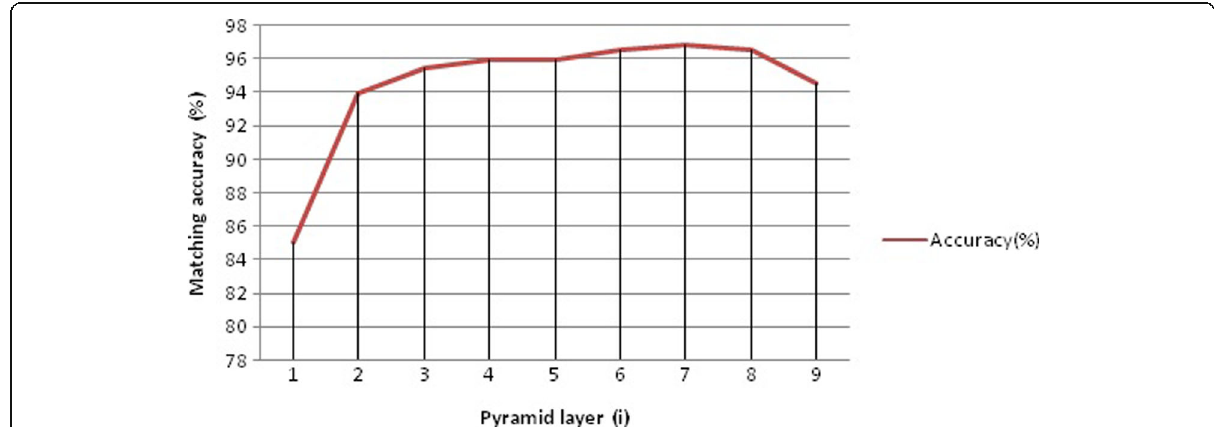
Fig. 16 Diagram of pyramid layer change and matching accuracy